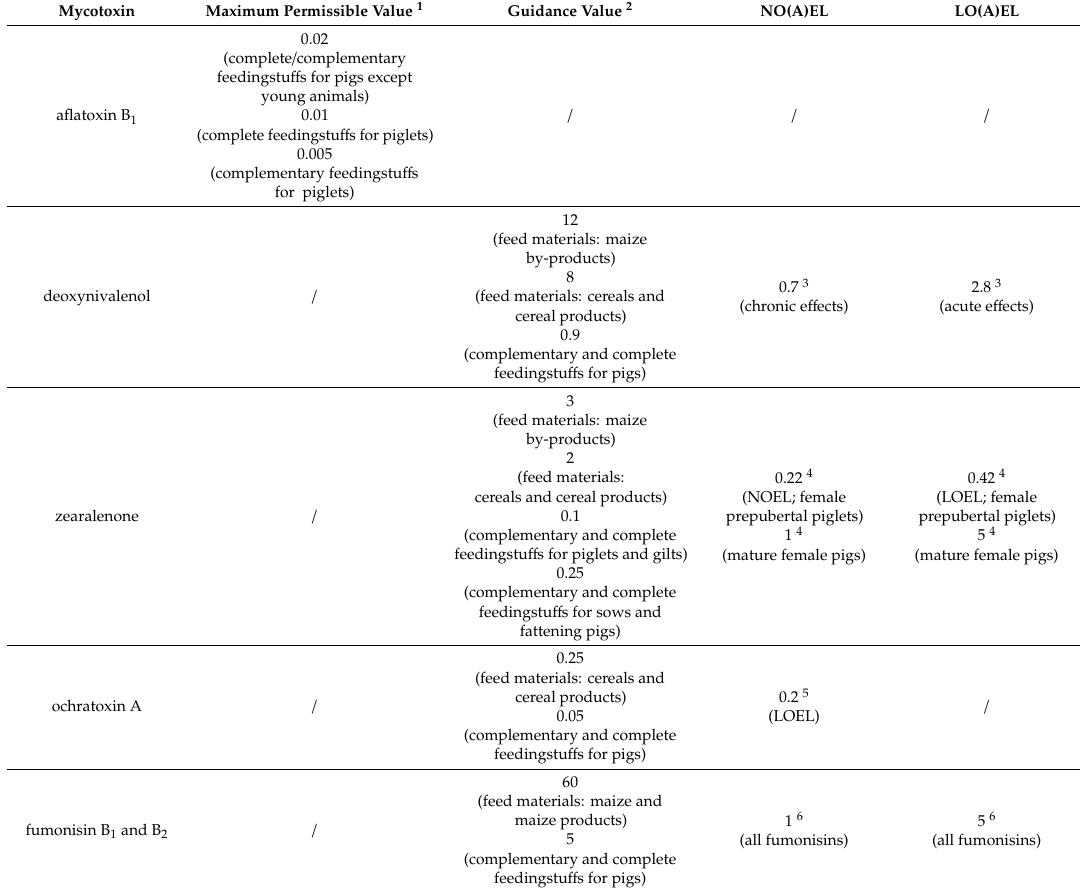
60 (feed materials: maize and maize